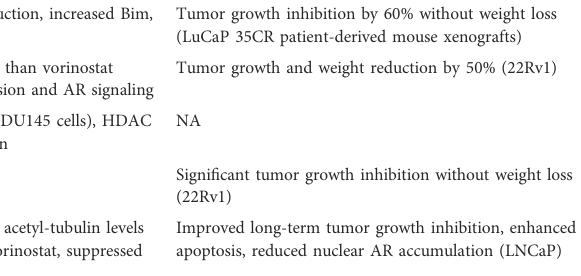
TABLE 3 | HDACi with anti-prostate cancer activities. Sl